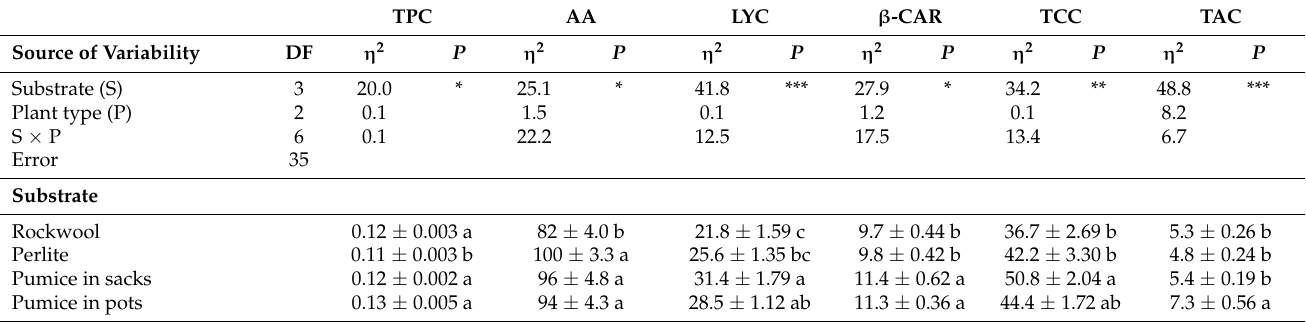
Table 10. Analysis of variance for average functional quality traits (total phenolic content: TPC, ascorbic acid: AA, lycopene: LYC, beta carotene: β -CAR, total carotenoid content: TCC, total antioxidant capacity: TAC) of tomato fruit harvested on 6 June. The fruit was obtained from self-rooted ‘Beef Bang F1’, ‘Beef Bang F1’ grafted onto ‘Defensor’, trained in single or double stem and grown hydroponically in four substrates (rockwool slabs, perlite in sacks, pumice in sacks and pumice in pots) in a